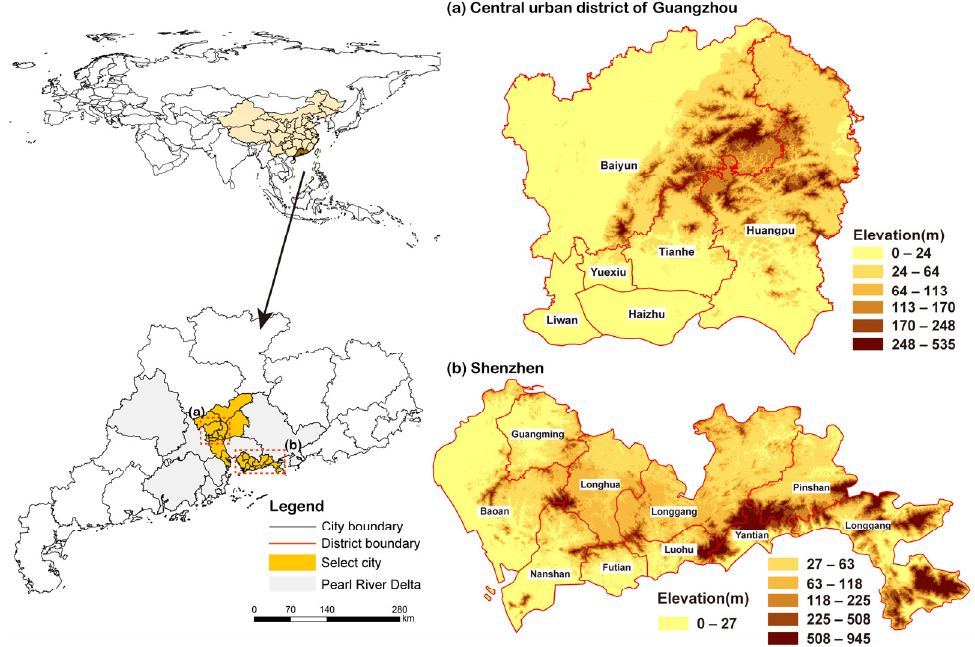
Figure 1. The location of the Guangzhou central urban districts and Shenzhen city.